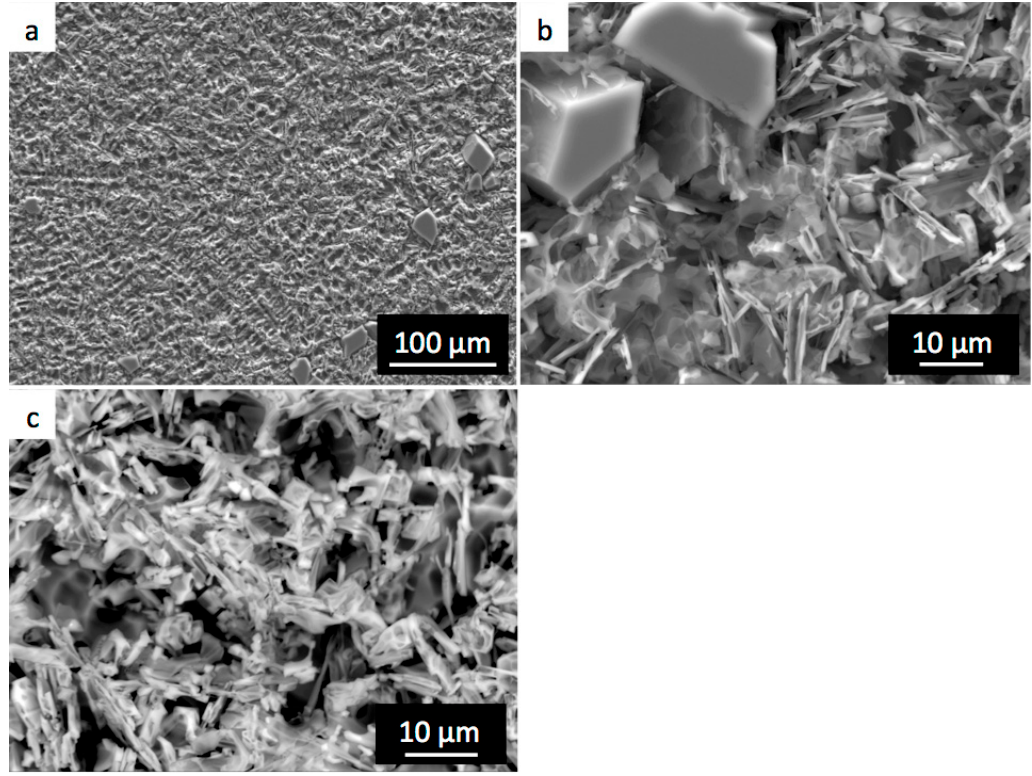
Figure 5. Solidification microstructure of the rapidly quenched Al-18%Si-2%Cu alloy in ( a ) lower and ( b,c ) higher magnification, deep etching. ( b , c ) higher magnification, deep